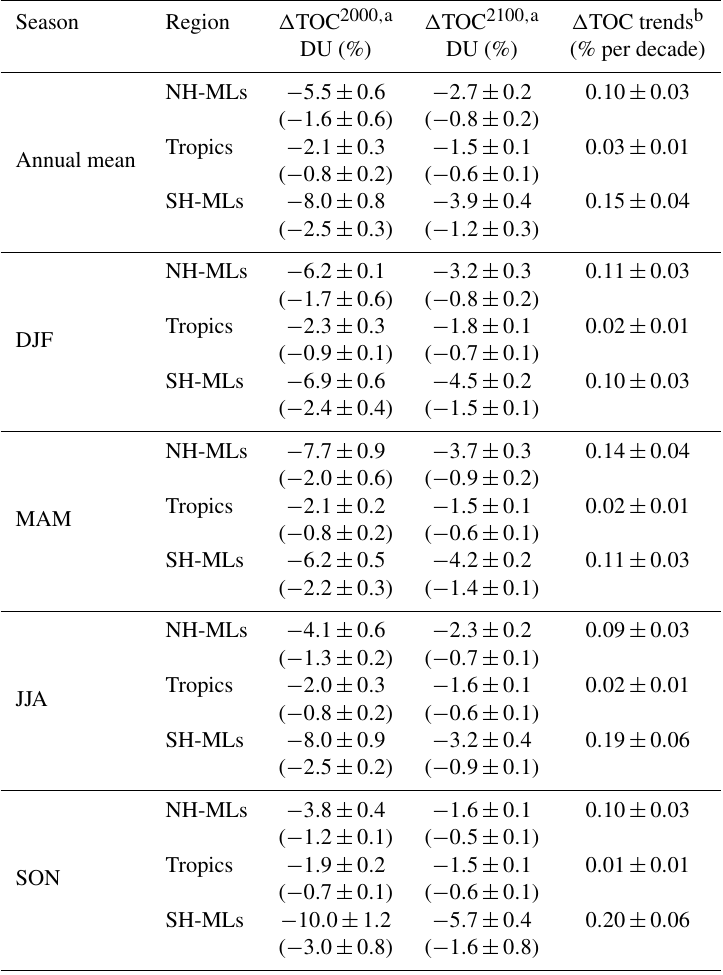
Table 1. Annual and seasonal TOC changes ( (cid:49) TOC) mediated by VSL Br at mid-latitudes and in the tropics for the present day and the end of the 21st century as well as the (cid:49) TOC trends (% per decade) over the